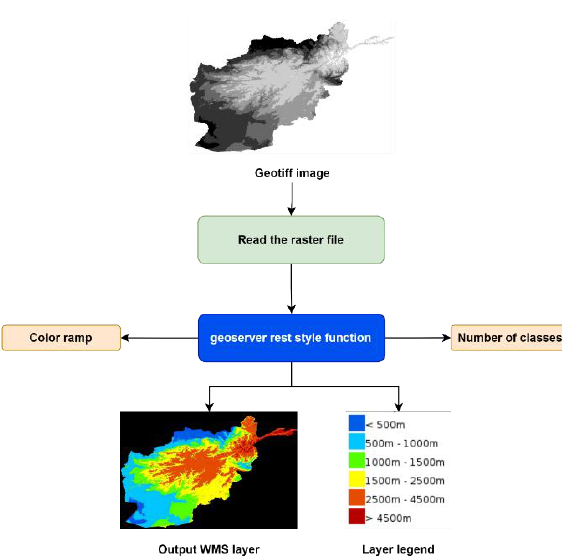
Figure 5. Process of generation of WMS layer of raster dataset using geoserver-rest. The input data is the altitude zones of